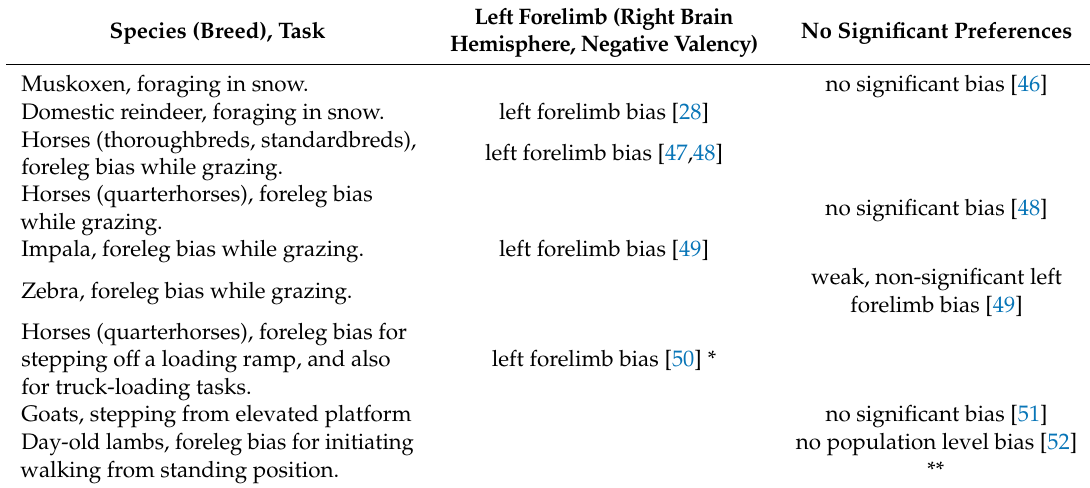
Table 2. Forelimb preferences in ungulate species performing specific motor tasks. Note there is no known report of significant right forelimb preferences (left brain hemisphere, positive valency) for population-level motor